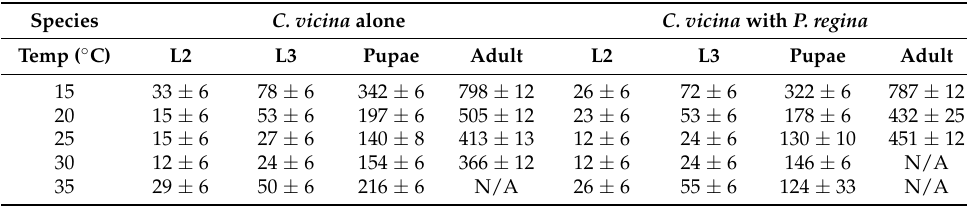
Table 3. Mean minimum development times (h) to reach each life stage starting from 1 h old first instar larvae for C. vicina when developing with conspecifics ( C. vicina alone) and heterospecifics ( C. vicina with P. regina ). Variation around the mean is presented as the greater of either half the sampling interval (6 h for second instar to pupal stages, 12 h for adult stage) or the calculated standard error. N/A indicates all individuals died prior to reaching this